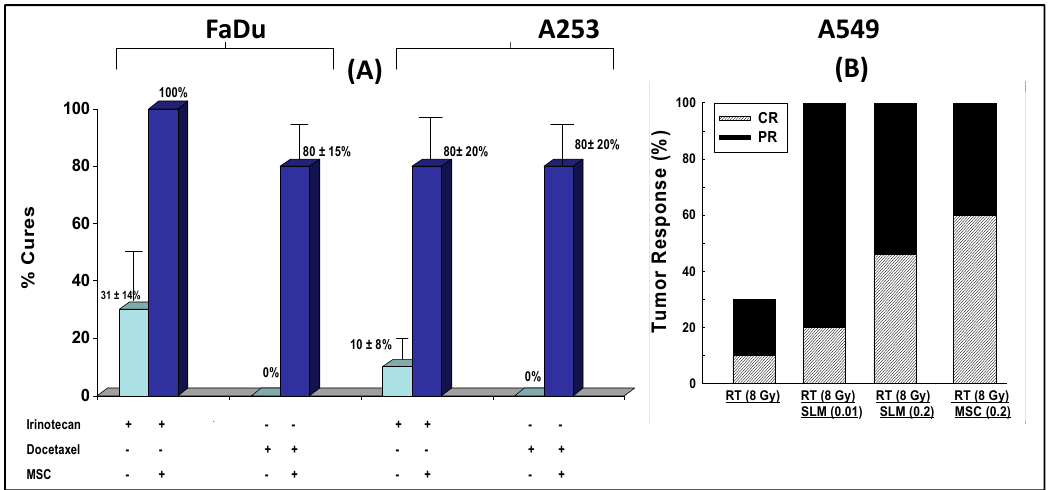
Figure 6. Antitumor activity of MSC in combination with irinotecan and docetaxel in nude mice bearing human head-and-neck cancer cells, FaDU and A253 ( A ), and radiation-treated A549 lung carcinoma ( B ). MSC was administered orally daily for seven days and concurrently with anticancer therapies administered on day seven [82].